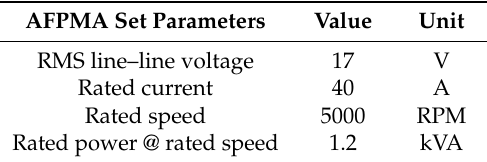
Figure 2. AFPMA rotor and stator main parameters. Table 1. AFPMA Requirements.